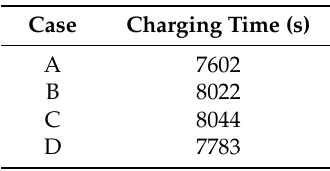
Figure 5. Simulation results of charging equalization. ( a ) Case A: no equalization; ( b ) Case B: SOC (State of Charge) of C 0 = 2%; ( c ) Case C: SOC of C 0 = 50%; and ( d ) Case D: SOC of C 0 = 98%. Table 1. Charging time comparison.